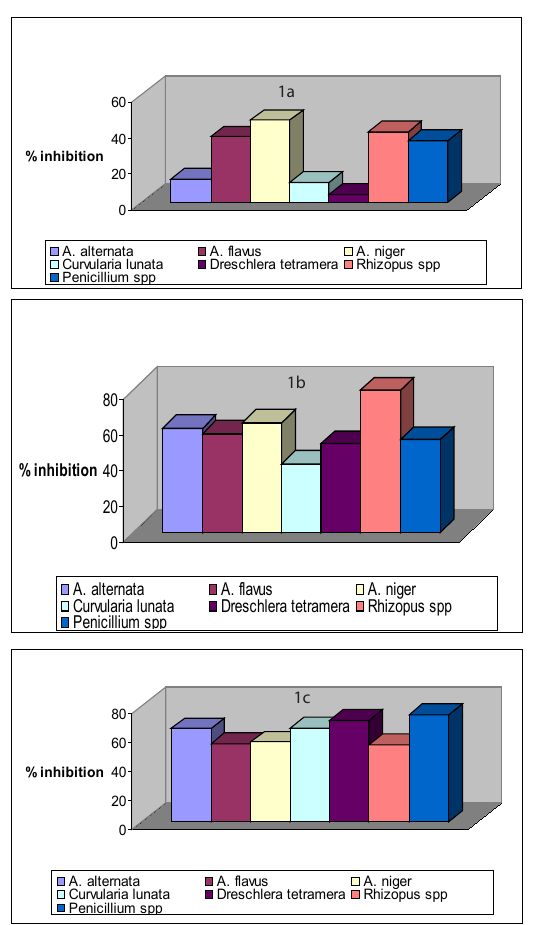
Figure 3. Effect of thiourea derivatives (1a-c) on the % inhibition growth of seven different